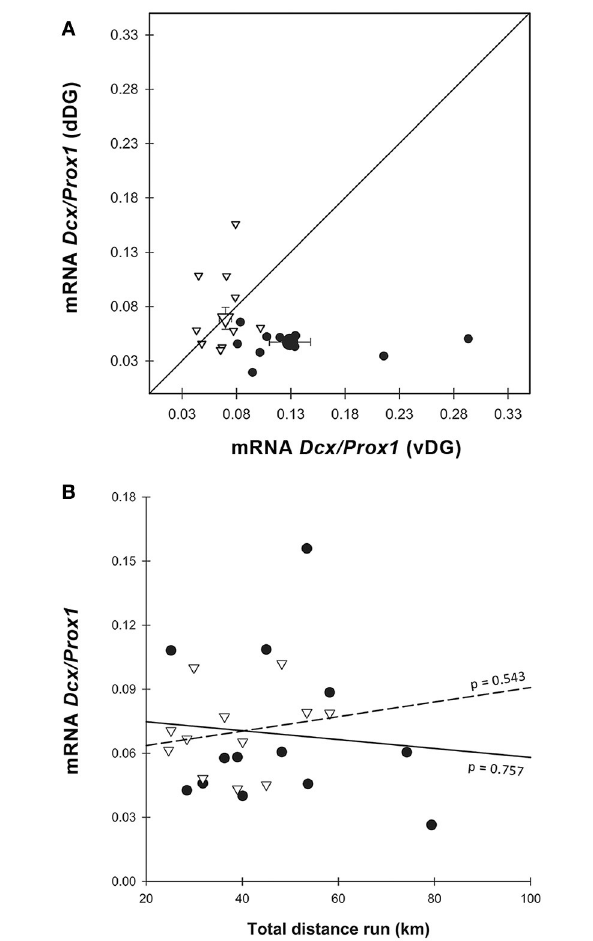
FIGURE 5 | DCX protein expression. (A) DCX protein content normalized over PROX1 was significantly higher in E-dDG than in C-dDG and E-vDG ( χ 2 = 22.938, p < 0.001), while in C-vDG it was higher than in C-dDG ( p = 0.003). As in Figures 3G, 4A , the data points representing the enriched group lie to the left and above those representing the control animals. Legend for (A) as in Figure 3G. (B) The effect of distance run, plotted against DCX protein expression showed no significant effects. Legend for (B) as in Figure 3H